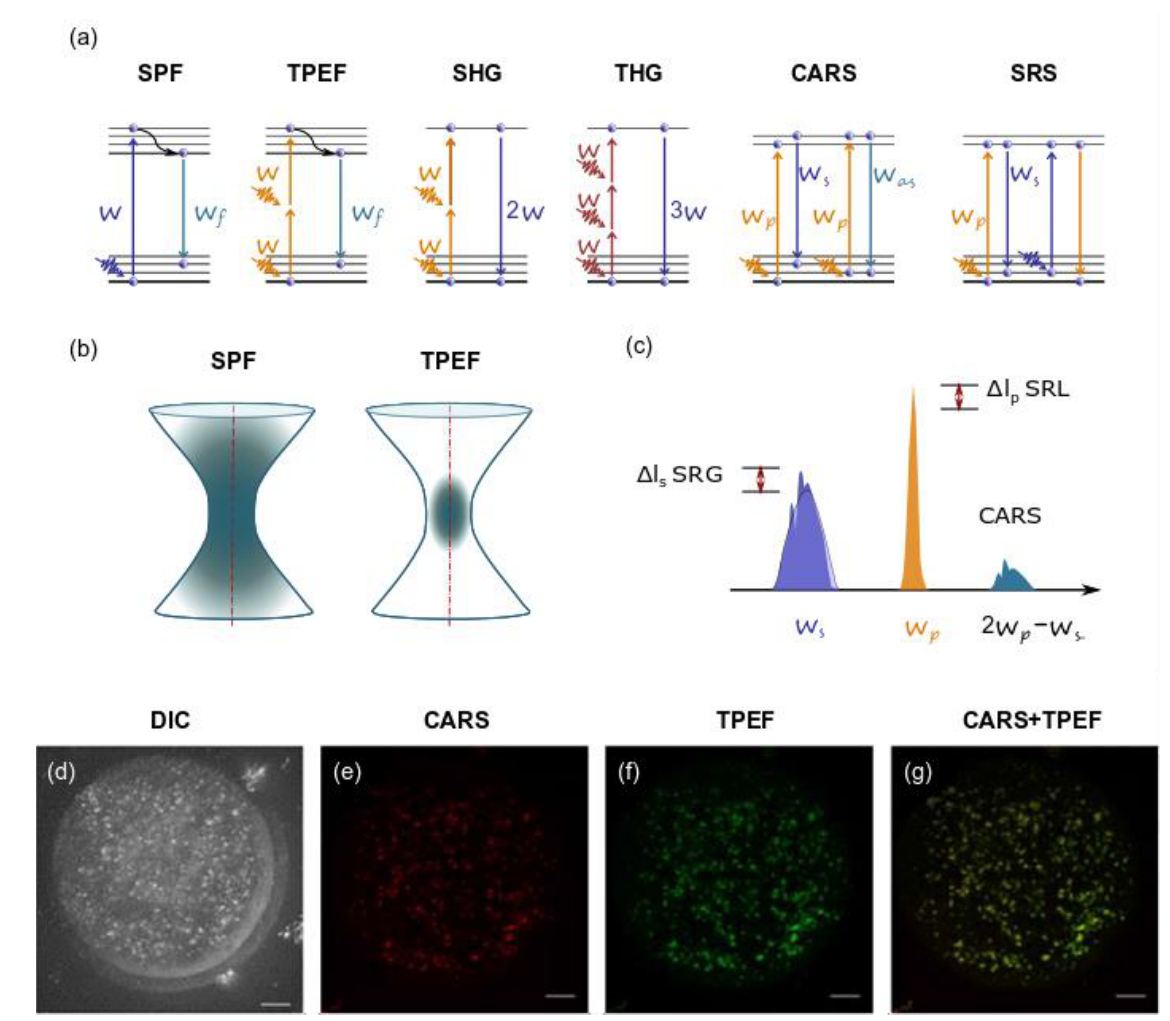
Figure 3. Nonlinear microscopy modalities: ( a ) diagrams (from left to right) for single-photon (SPF) and two-photon excited (TPEF) fluorescence, second harmonic (SHG) and third harmonic (THG) generation, coherent anti-Stokes Raman scattering (CARS) and stimulated Raman scattering (SRS); ( b ) excited volume in case of SPF and TPEF; ( c ) schematic representation of the excitation and emission frequencies involved in SRS and CARS: in evidence the SRS signal in terms of gain (SRG) on the Stokes pulse or the loss (SRL) on the pump pulse. ( a – c ) are redrawn from an open-access (CC BY license) source; ref. [77], Authors: Parodi, Jacchetti, Osellame, Cerullo, Polli and Raimondi. Copyright © 2021, Frontiers. ( d – g ) An example of CARS and TPEF images of fixed mouse egg: ( d ) DIC image of germinal vesicle mouse egg, ( e ) false-colored CARS image at wavenumber 2850 cm − 1 and ( f ) TPEF xy image, accompanied by ( g ) false-colored overlays of germinal vesicle egg stained with BODIPY lipid stain. Scale bar: 10 µ m. Fragment ( d – g ) is adapted with permission from an open-access (CC BY license) source; ref. [86] Copyright © 2021. Published by The Company of Biologists